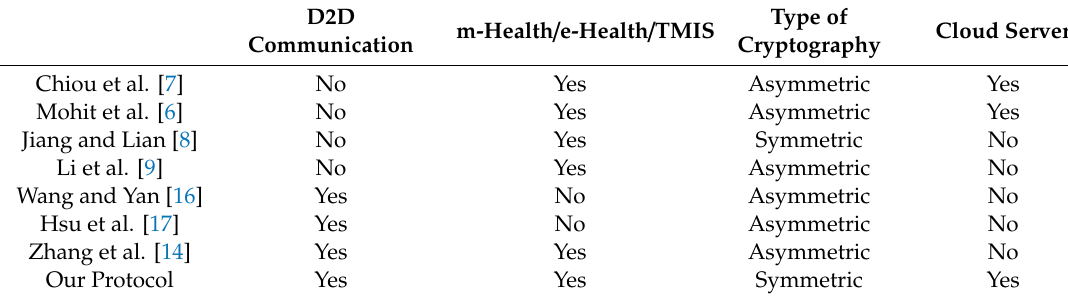
Table 1. Comparison among some